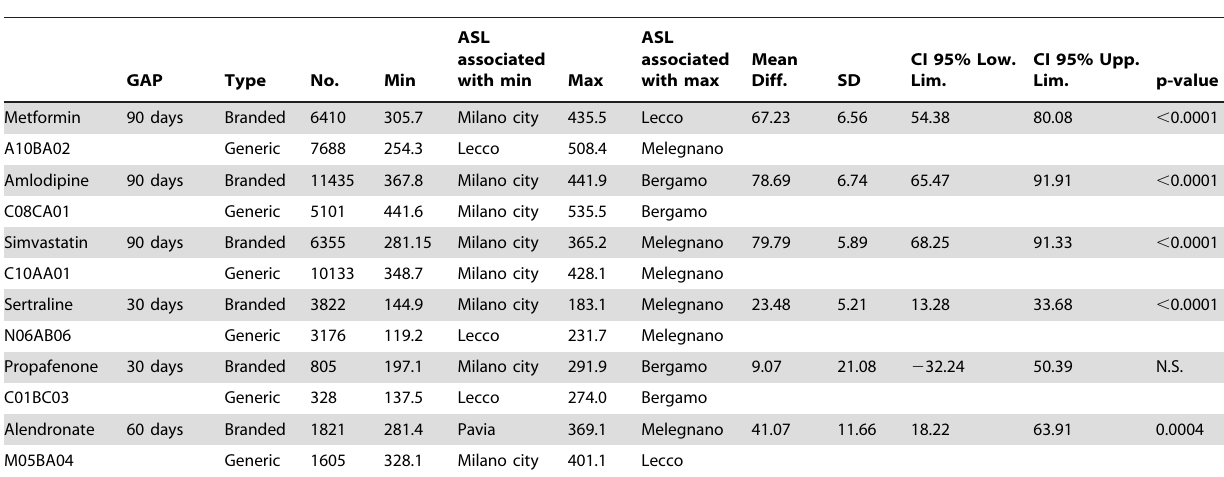
Table 2. Analysis of persistence in therapy: continuation of therapy (DDD duration) for the recommended period of time.